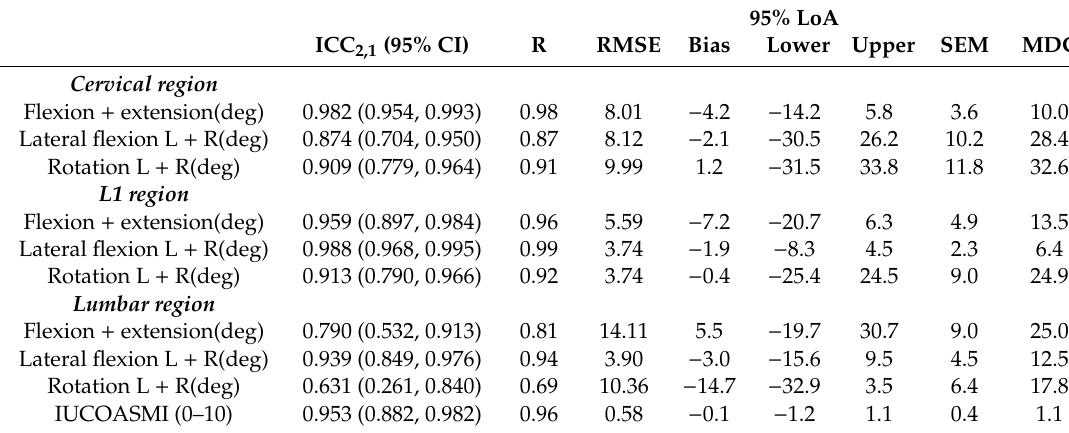
Table 3. Agreement between measures obtained by the IMU sensor-based system and motion capture.